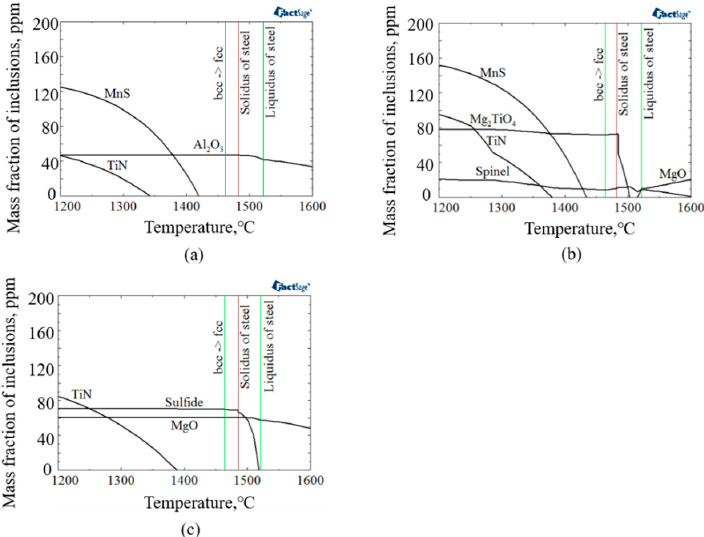
Figure 9. Thermodynamic calculation results for inclusion evolution during solidification of ( a ) A, ( b ) LM, and ( c ) HM.